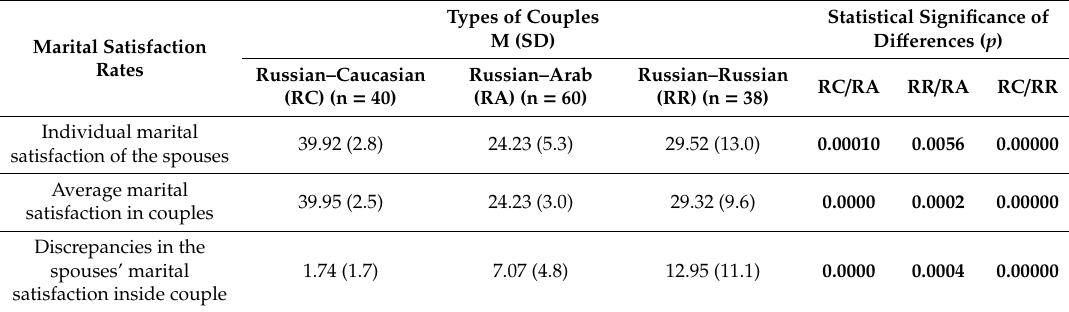
Table 6. Marital satisfaction in mono-cultural, inter-ethnic and inter-faith